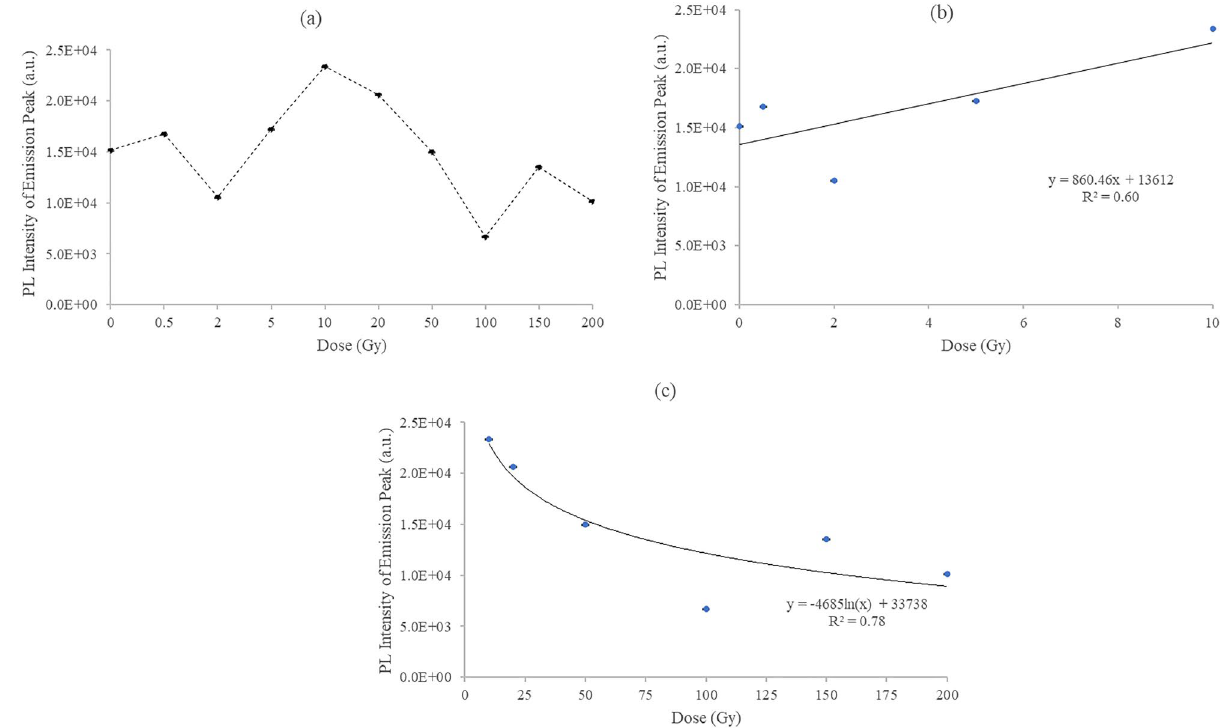
Figure 7. ( a ) Maximum PL intensity extracted from the emission peaks of PL spectra. The dashed line is a guide to the eye; ( b , c ) show the PL intensity of the emission peak plotted against the lower and higher dose regimes respectively. The error bars are one standard deviation values of the data